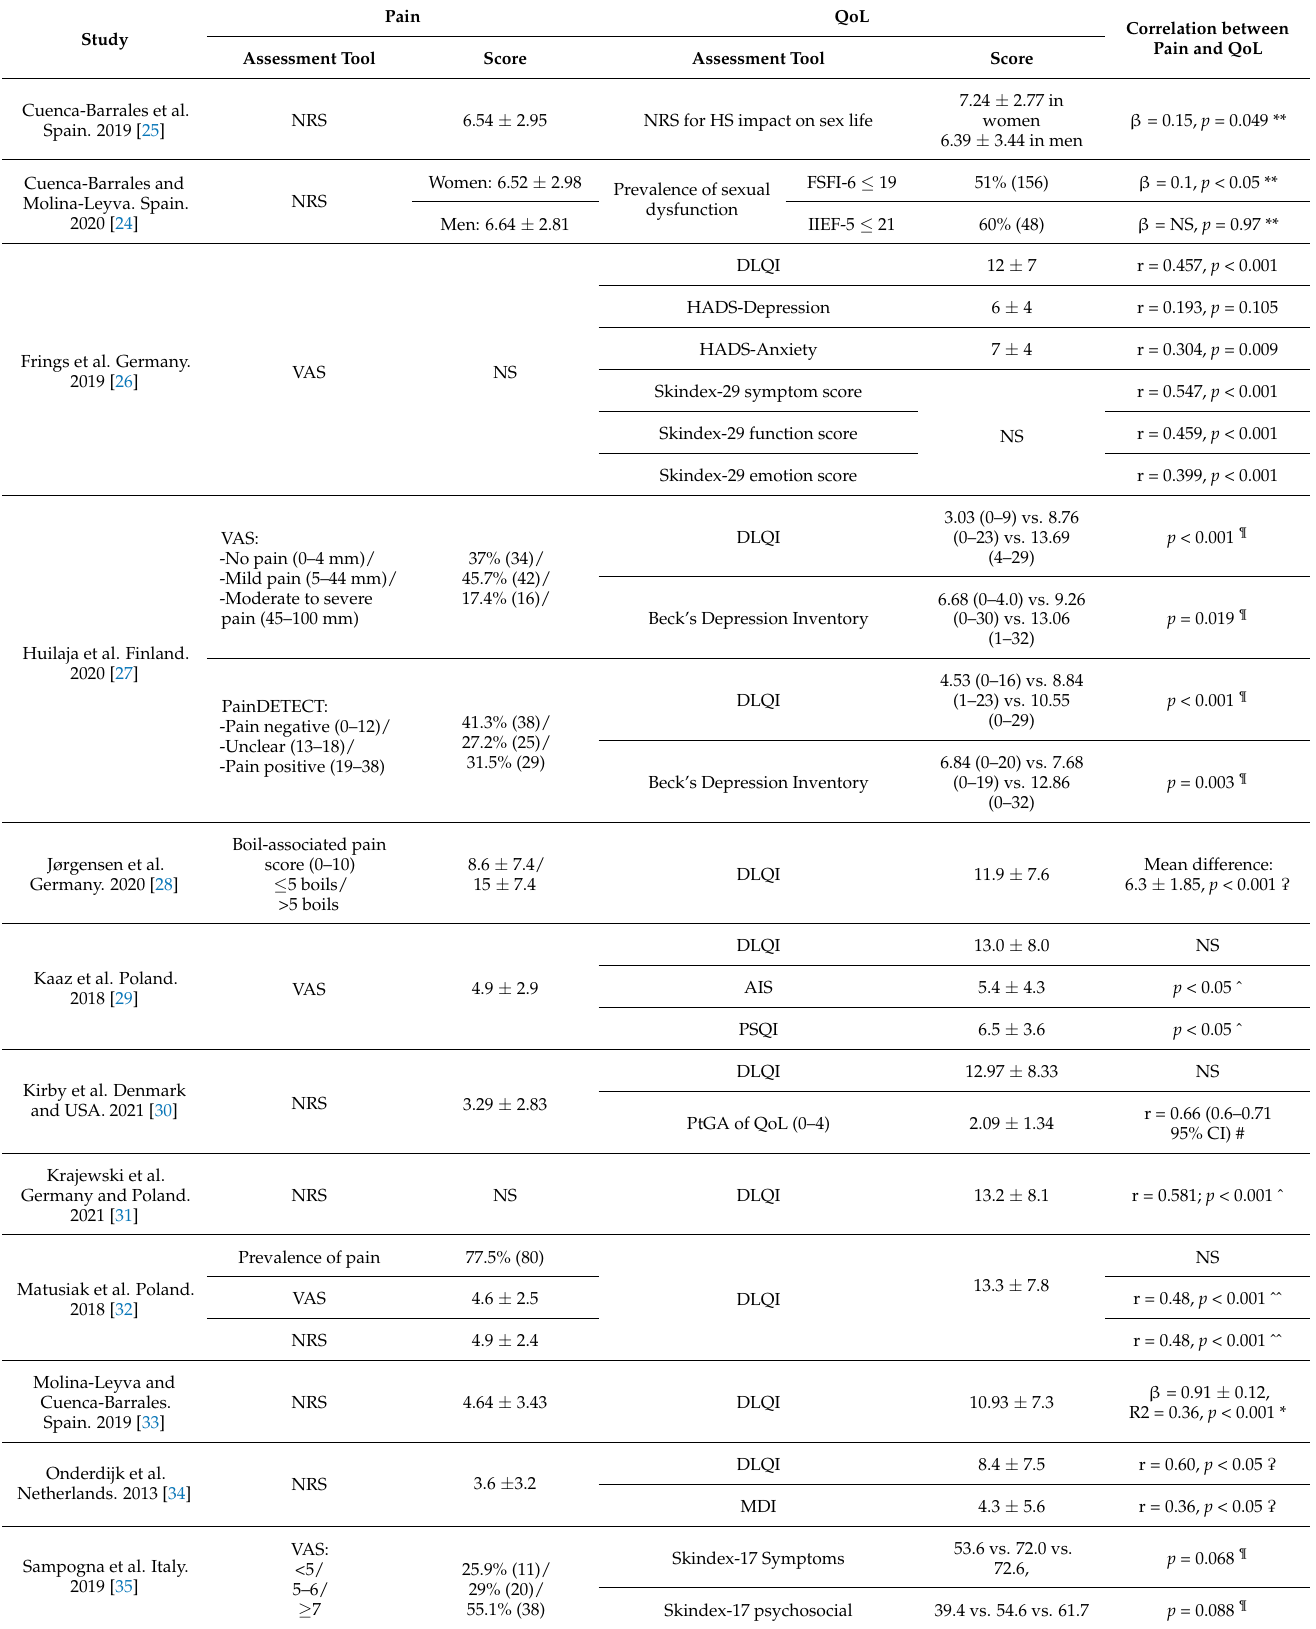
Table 2. Studies regarding pain impact on